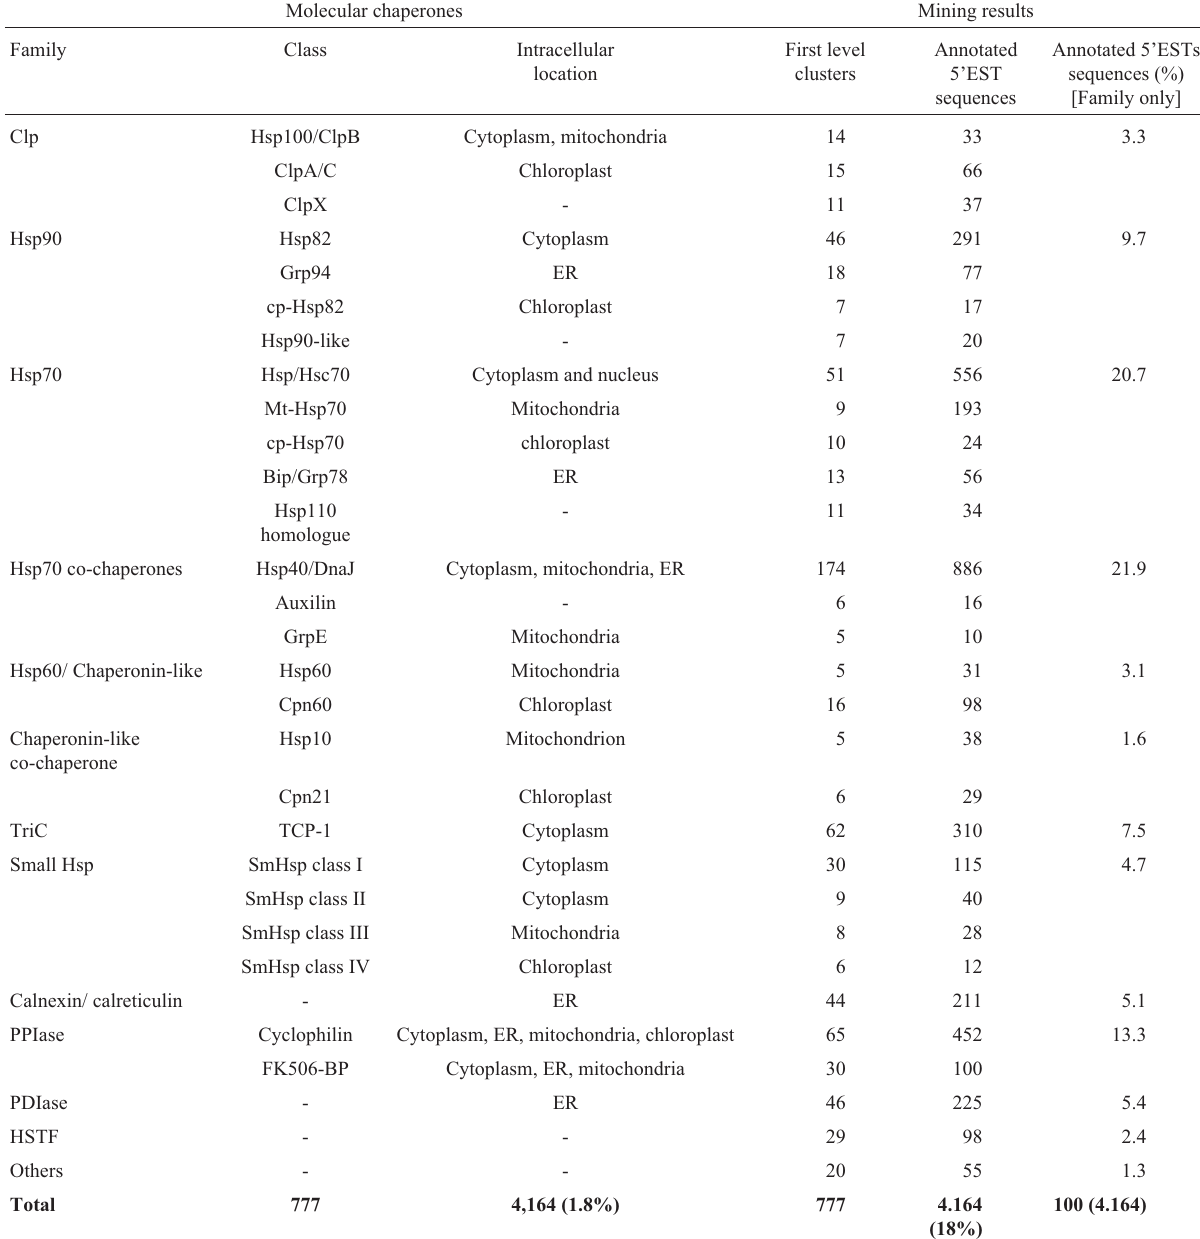
Table I - The main chaperone families and classes, their cellular location and the mining results. Molecular